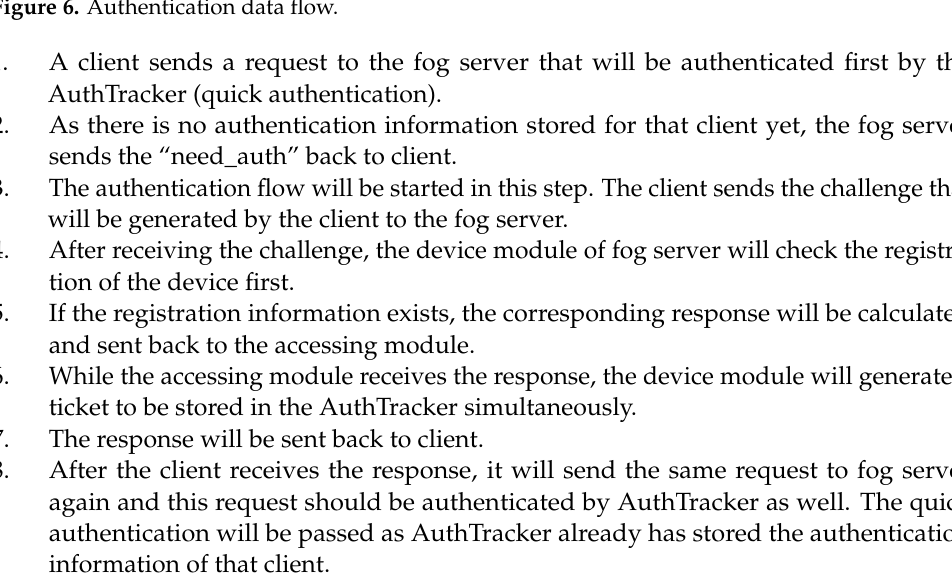
Figure 6. Authentication data